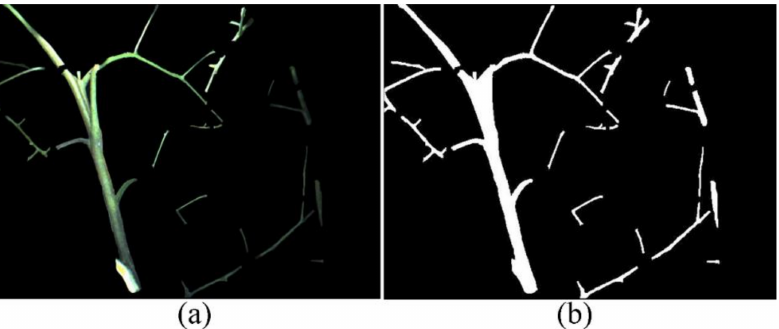
Figure 6. Ground truth and its binary image: ( a ) ground truth of stems; ( b ) binary image of stem ground truth.